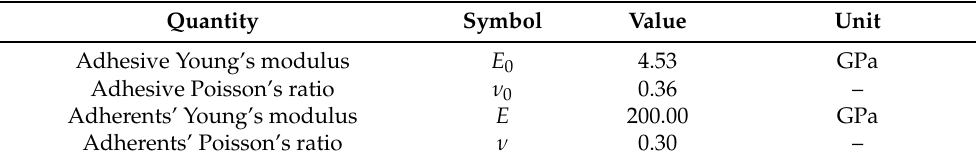
Table 2. Mechanical properties of the joint materials [9].